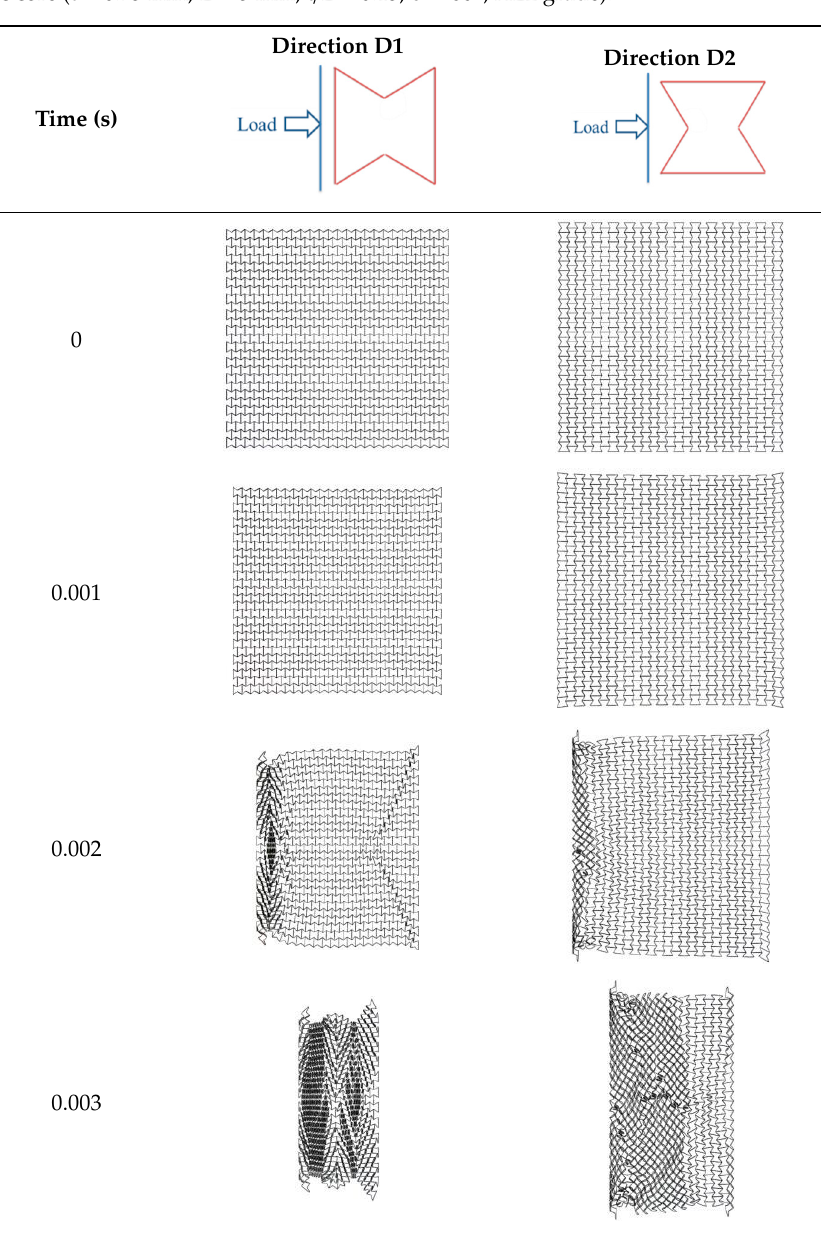
Table 4. Loading directions D1 and D2 and their effect on the collapse mode and deformation of an